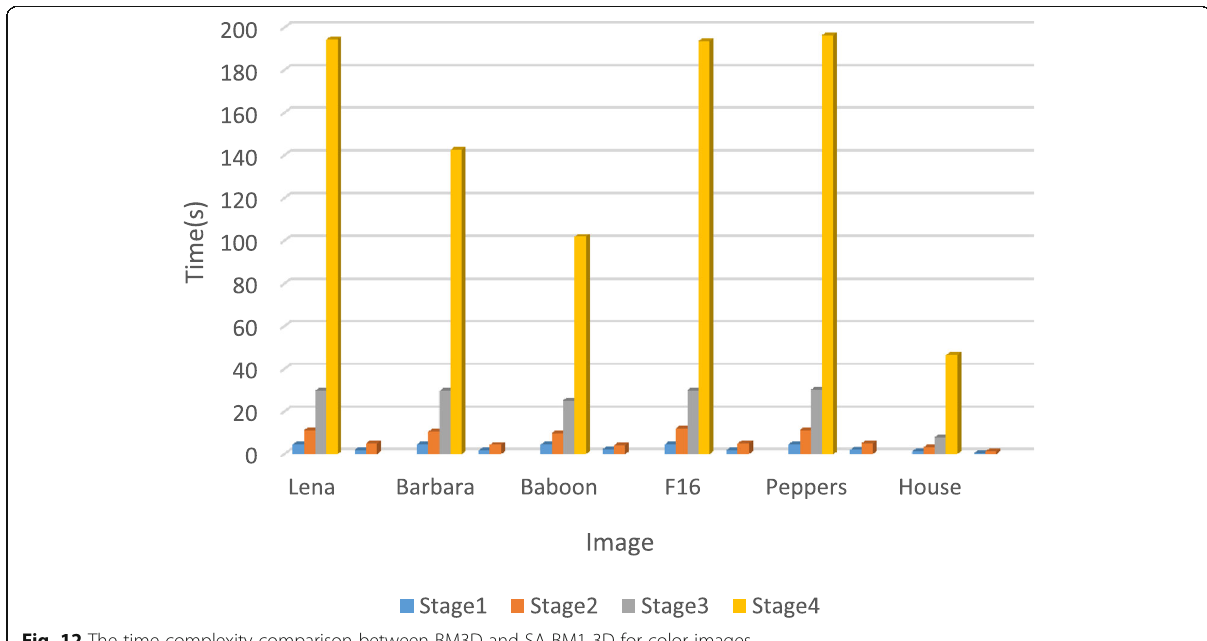
Fig. 12 The time complexity comparison between BM3D and SA-BM1-3D for color